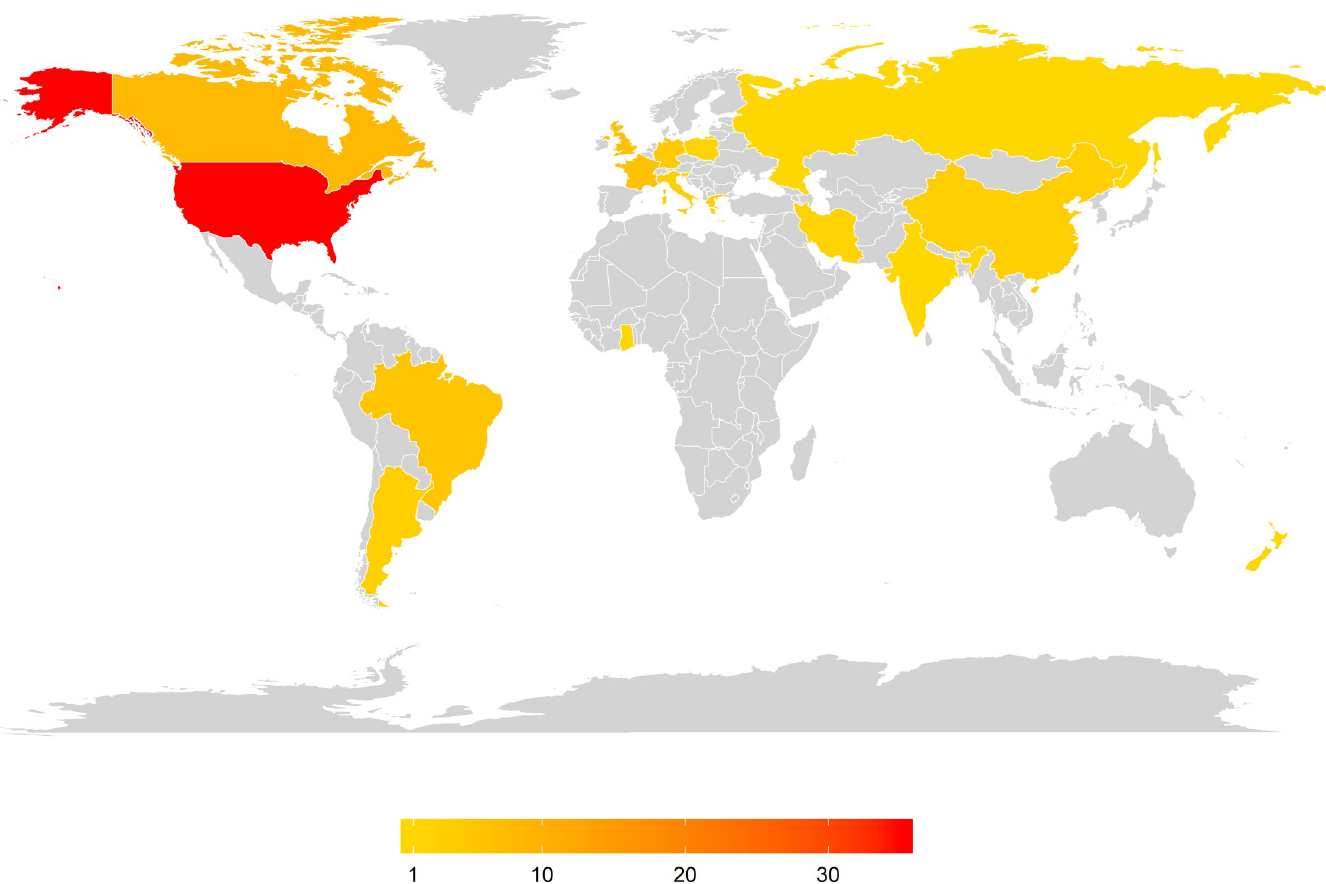
Fig 2. The number of studies undertaken in each country worldwide (grey = 0 studies). The majority of studies have been undertaken in North America and Europe, followed by South America.